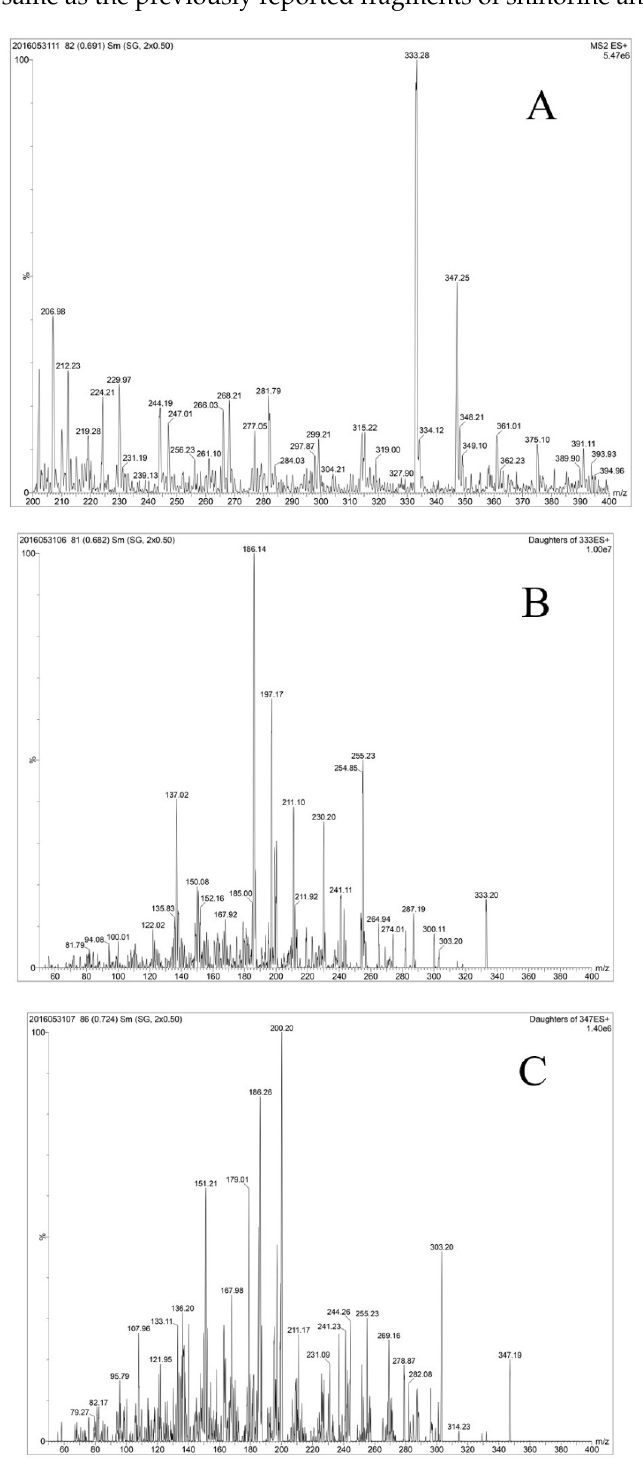
Figure 5. UPLC-MS-MS analysis of the MAAs in Aph. flos-aquae CHAB5921. ( A ) MS1 of the extraction of strains CHAB5921. ( B ) MS2 daughter fragment analysis of the fragment 333-shinorine. ( C ) MS2 daughter fragment analysis of fragment 347 porphyra-334.